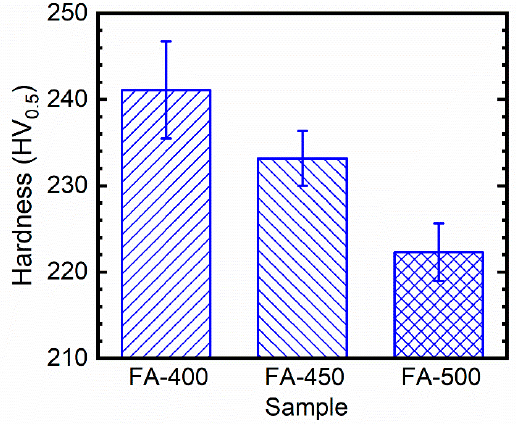
Figure 4. Hardness of the samples after final annealing.